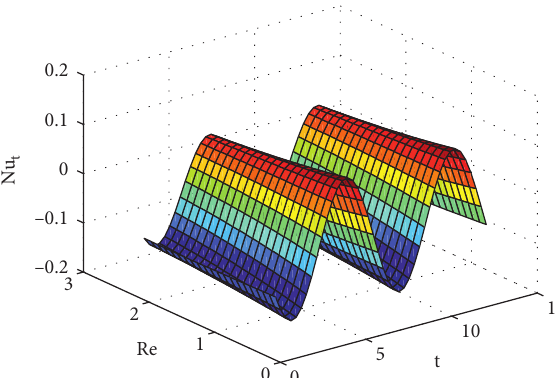
Figure 13: Effect of Rd and Re on “the Nusselt number distribution” when Ec � 1 , Ha � 0 . 5 , andPr � 21.